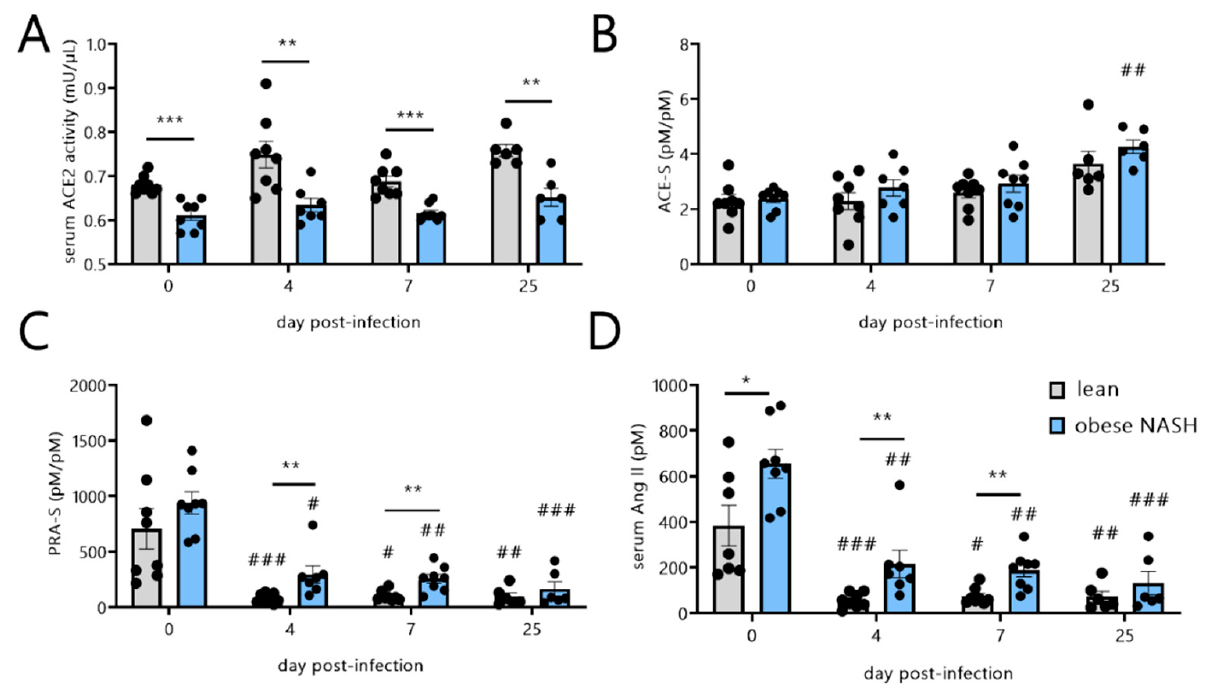
Figure 4. Effects of SARS-CoV-2 infection on serum ACE2, ACE, and the renin-angiotensin system activity levels in lean hamsters vs. obese NASH hamsters. Blood from mock-infected and SARS- CoV-2-infected lean hamsters and obese NASH hamsters were collected at the indicated timepoints post-infection. Serum ACE2 ( A ), ACE ( B ), and renin angiotensin ( C ) activities are depicted. Angio- tensin II levels are shown in ( D ). The data are expressed as the mean ± SD ( n = 6–8 animals/group). Significant differences were determined using the Mann–Whitney U test (* p < 0.05; ** p < 0.01, *** p < 0.001). The effect of SARS-CoV-2 infection is also depicted. The values were compared with those of mock-infected animals using a Kruskal–Wallis test and Dunn’s post-test (# p < 0.05, ## p < 0.01, and ### p < 0.001). ACE-S, angiotensin-converting enzyme activity (Ang II/Ang I); PRA-S, serum renin activity (Ang I + Ang II). Table 3. Equilibrium levels of circulating angiotensin peptides. Values are expressed in mean ± SD ( n = 6–8 animals/group). Angiotensin Peptides